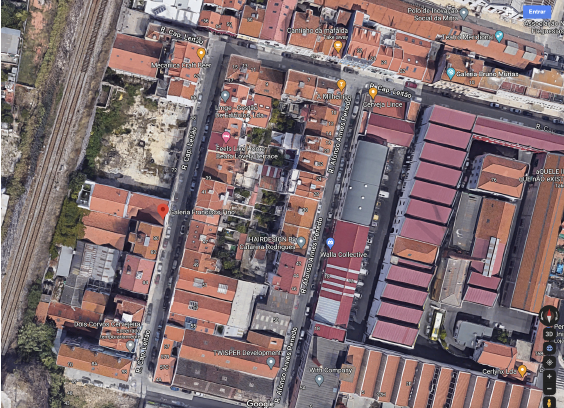
Figure 4. Site map (Google Maps).